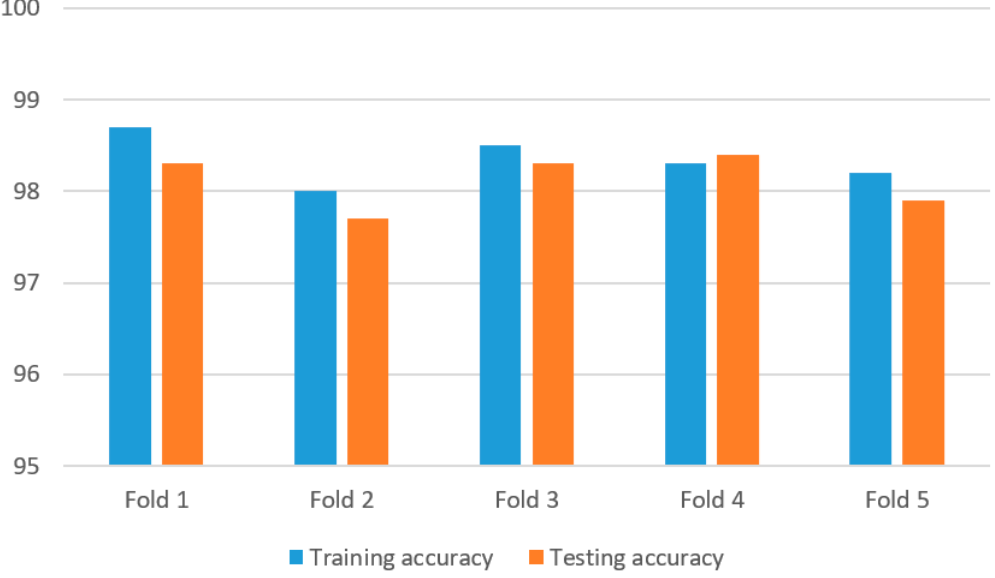
Figure 4. Accuracy of the 3D-2D-1D-CNN-based WTSVM on the ExtraSensory dataset.